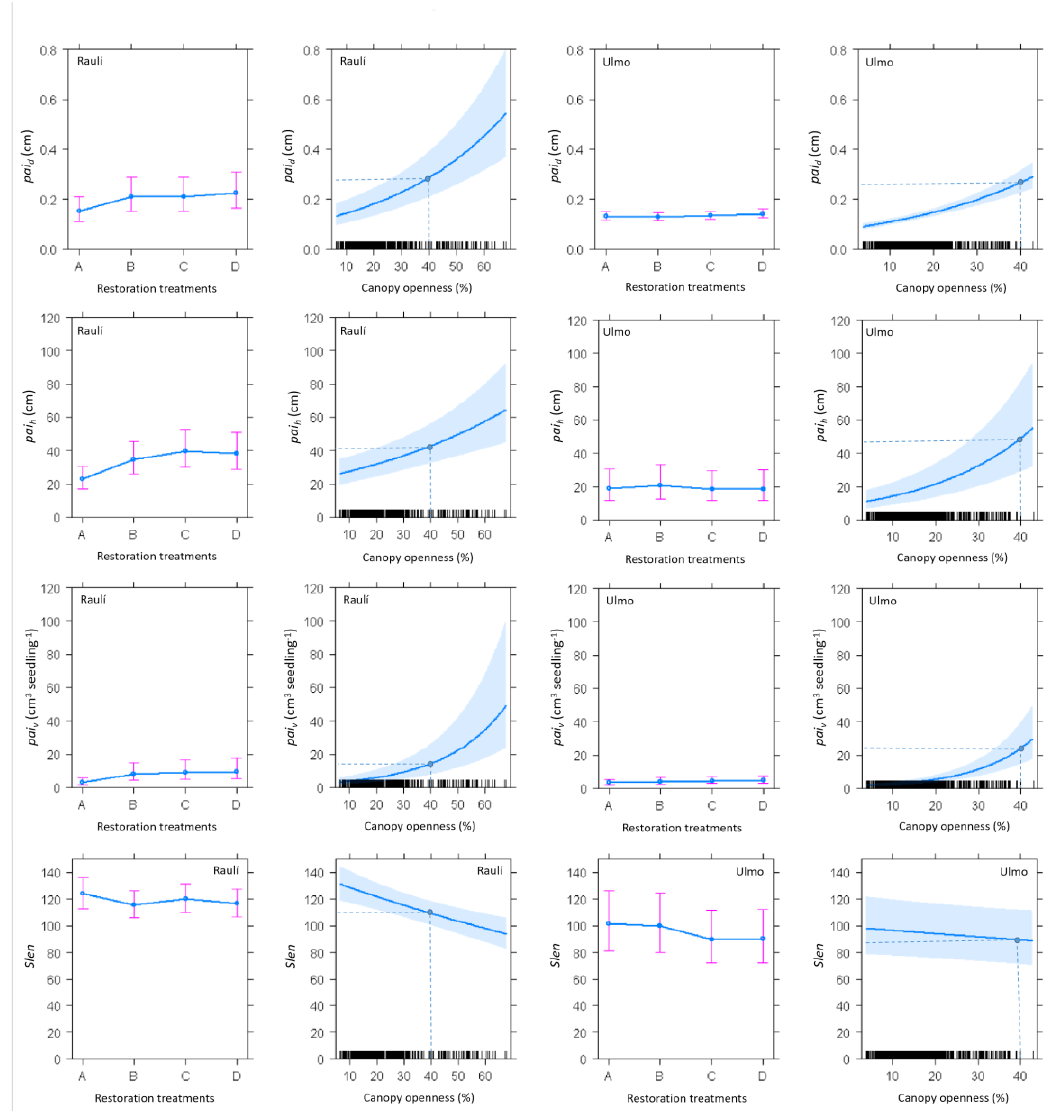
Figure 2. Expected value for each response variable for each species as a function of canopy openness, based on our proposed mixed-effects models. A 95% confidence interval is shown for each model by shadowed areas around the expected value. Dashed lines show the canopy openness at a level of 40%. The plots related to the restoration treatments show the mean and standard deviation for each of the four response variables measured for each species. The plots related to canopy openness show the fitted generalized linear mixed model (GLMM) with shadowed areas as the confidence intervals (95%). The plots related to restoration treatments show A: control (untreated plots), B: Improvement cut, C: Improvement cut and understory vegetation control, D: Improvement cut, understory vegetation control, and soil scarification.